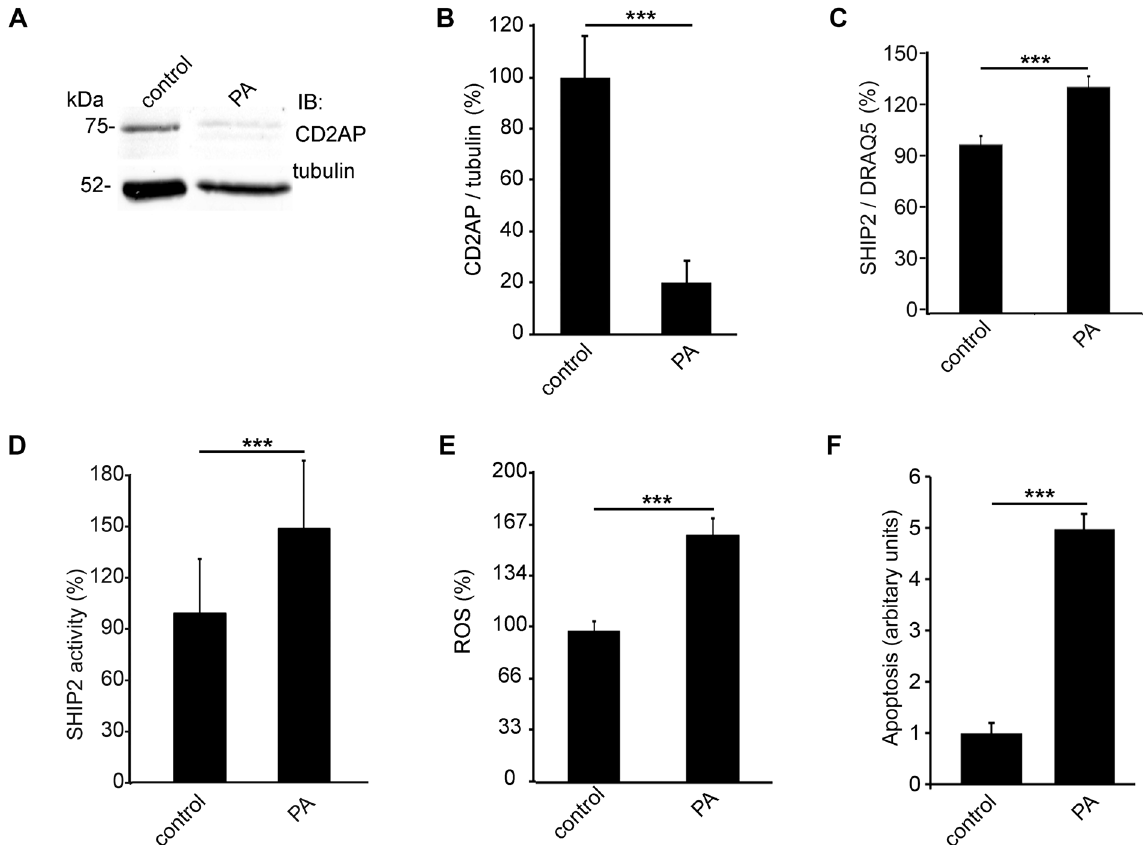
Figure 5. PA-treatment decreases CD2AP expression and increases SHIP2 activity, ROS production and apoptosis in cultured human podocytes. ( A ) Representative immunoblot for CD2AP after PA-treatment. Tubulin is included as a loading control. ( B ) Quantification of CD2AP after PA-treatment in immunoblots like in ( A ) shows a decrease in CD2AP expression. ( C ) Quantification of SHIP2 expression in podocytes treated with PA by In-Cell Western shows that the expression of SHIP2 is increased by PA-treatment. DRAQ5 TM was used for normalization. ( D ) PA-treatment increases SHIP2 activity in human podocytes. ( E ) PA increases ROS generation as visualized by an increase in the intensity of DCFH-DA fluorescent probe. Hoechst 33342 was used for normalization. ( F ) Flow cytometry of cultured human podocytes stained with annexin V and 7-AAD double labelling shows that PA-treatment increases podocyte apoptosis. The experiments were performed three times with four ( B , D , F ), 24 ( C ) or 48 ( E ) replicates in each experiment. The bars ( B – F ) show the mean expression in arbitrary units (error bars STDEV). *** p < 0.001, Student’s